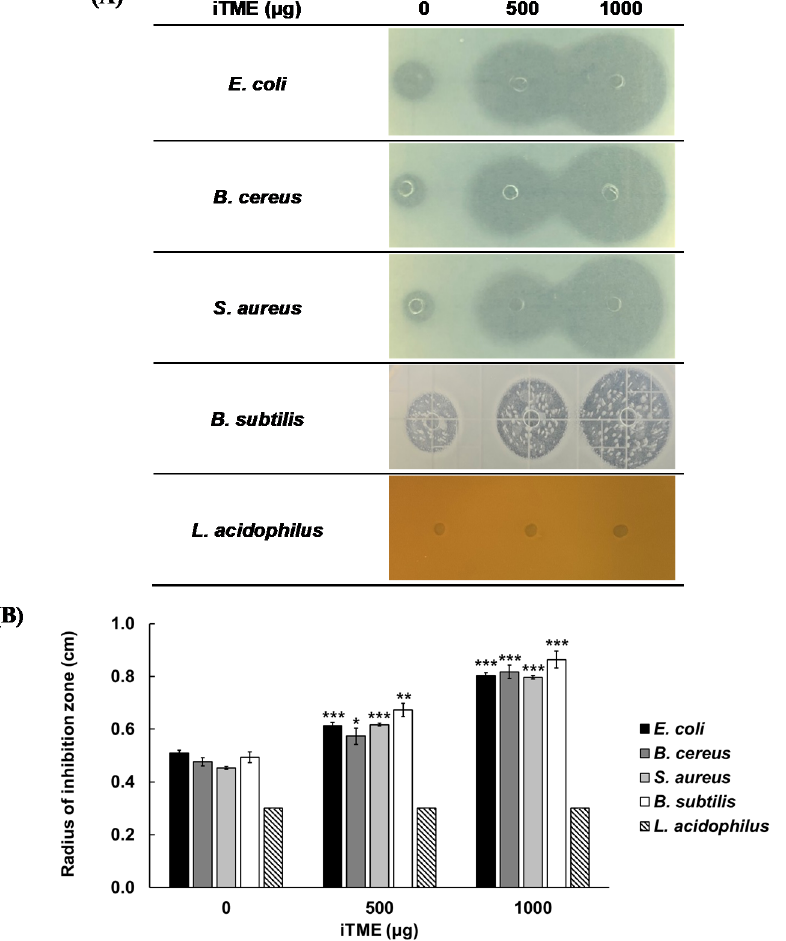
Figure 2. Evaluation of the antibacterial activities of immunized Tenebrio molitor larvae extract (iTME) against harmful bacteria ( Escherichia coli , Bacillus cereus , and Staphylococcus aureus ), and beneficial bacteria ( Bacillus subtilis , Lactobacillus acidophilus ) using radial diffusion assay (RDA) ( A ) and by measuring the radius of inhibition zone ( B ), Values are reported as mean ± standard deviation of triplicate experiments. * p < 0.05, ** p < 0.01, and *** p < 0.001 represent significant differences between 0 µg and 500, 1000 µg, respectively.